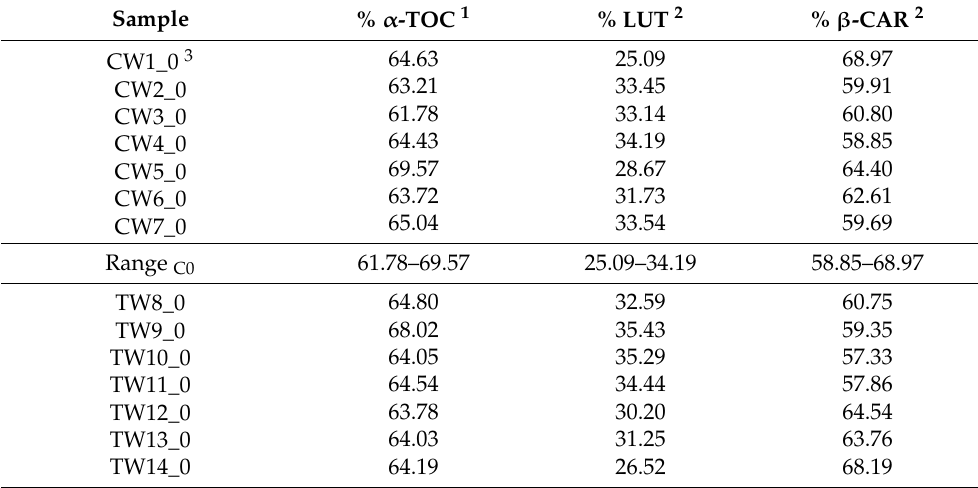
Figure A1. Biplot of 2D−graph of PCA for the 28 spring-produced samples; the shown components explain 90.7% of the total variability. We have chosen to highlight clustering to evidence the slight enrichment of antioxidants after grazing seldom empowered by enriched diet (spots belonging to T1 group). The four groups define control cows (C) and cows with enriched diet (T), after (1) and before (0) the grazing feeding. Table A1. Percentage of the most representative compounds in “Ragusano” cheeses produced in